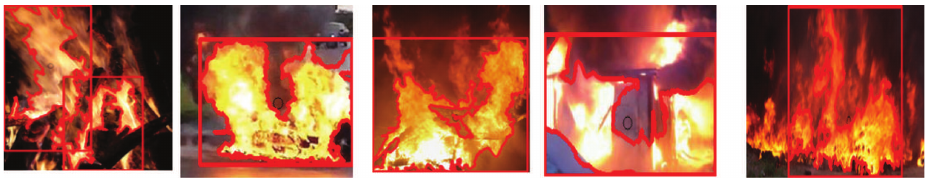
Figure 12: Sample Images Whose Centroids are not in the Candidate